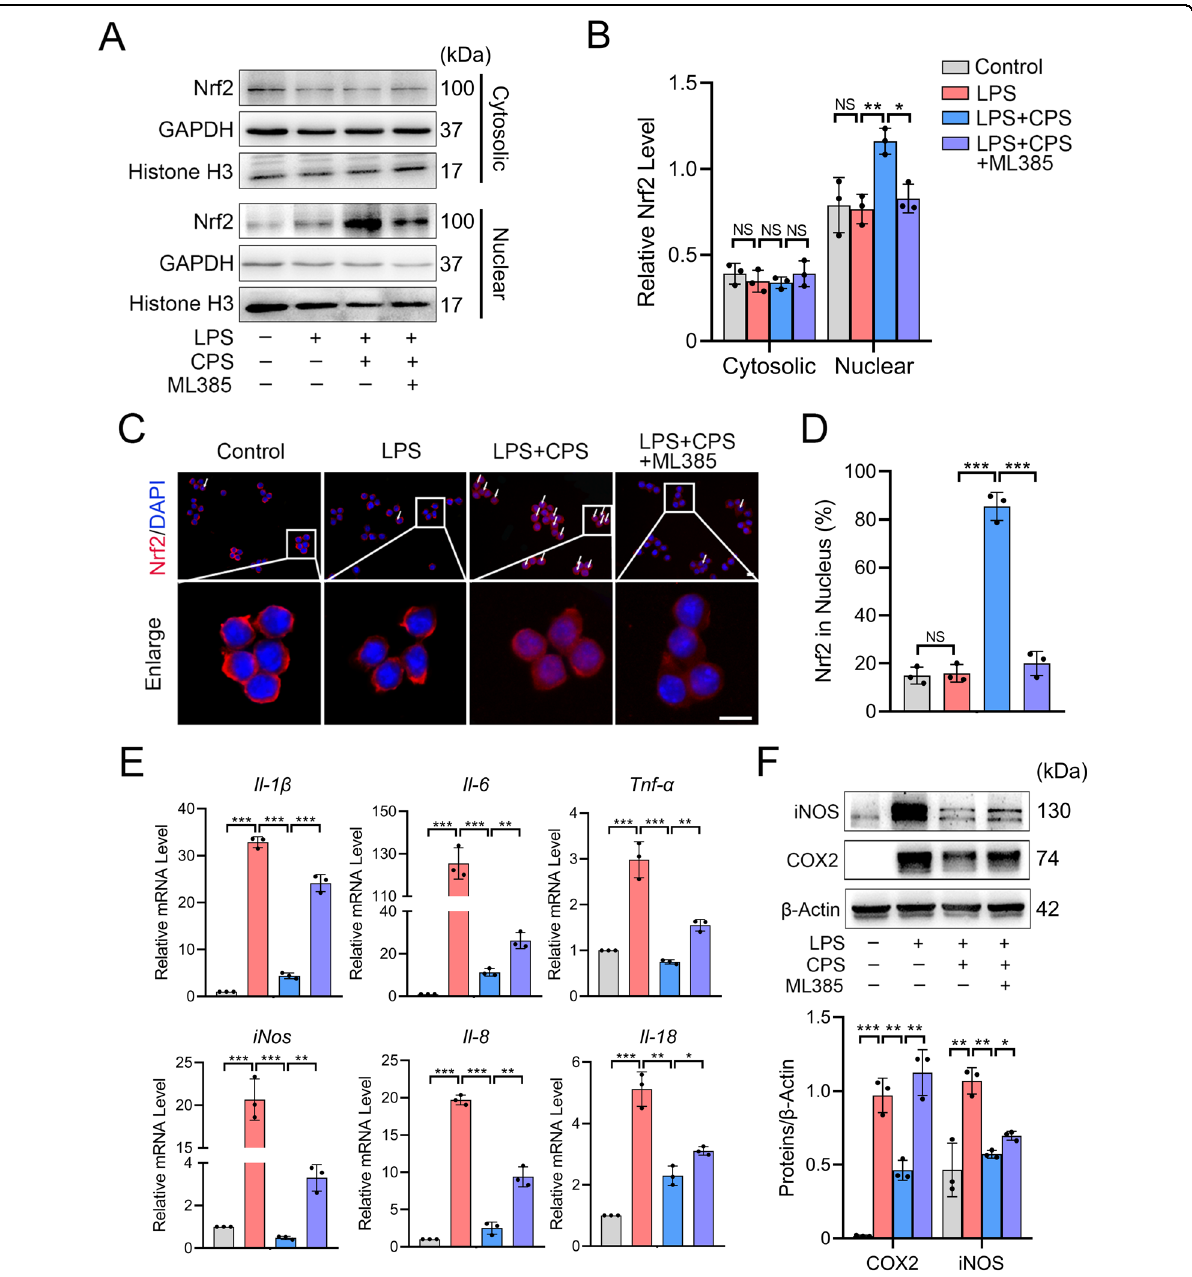
Fig. 4 TRPV1 promotes the nuclear translocation of Nrf2 and inhibits M1 macrophage polarization in RAW264.7 cells. A Western blot and B quantitative analysis of cytosolic and nuclear Nrf2 protein levels in cells treated with LPS and LPS + CPS with or without ML385 for 3 h. C Immuno fl uorescence image of Nrf2 and D its quantitative analysis in RAW264.7 cells treated with LPS and LPS + CPS with or without ML385 for 3 h. White arrow: cells with Nrf2 nuclear translocation. E qPCR analysis of mRNA levels of M1 macrophage markers in RAW264.7 cells treated with LPS and LPS + CPS with or without ML385 for 24 h. F Western blot and quantitative analysis of iNOS and COX2 protein expression levels in RAW264.7 cells treated with LPS and LPS + CPS with or without ML385 for 48 h. Data ( n = 3) are shown as mean ± SD. * P < 0.05; ** P < 0.01; *** P < 0.001. Scale bars: 10 μ m. NS nonsigni fi